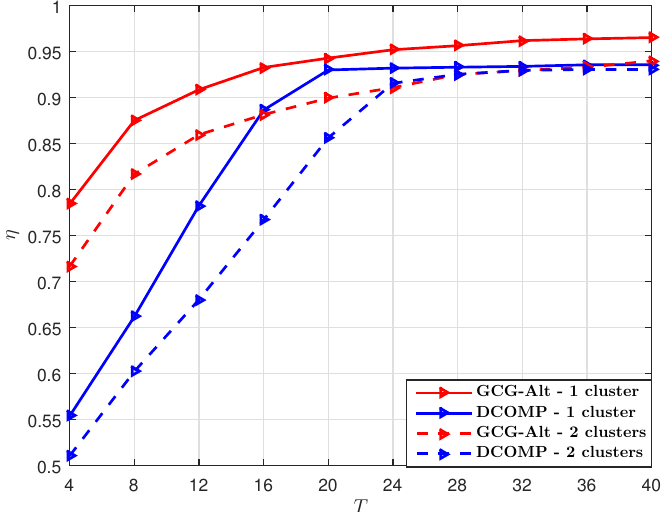
Figure 3. Comparison of η of the GCG-Alt estimator and the DCOMP estimator under the ULA system, where N t = 64, N r = 16,PNR = 10 dB, and S =